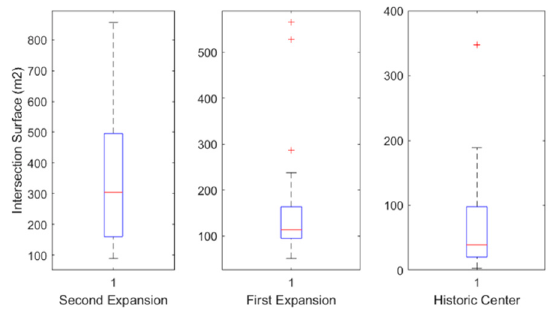
Figure 8. Comparison of intersection surfaces for the three case study areas.